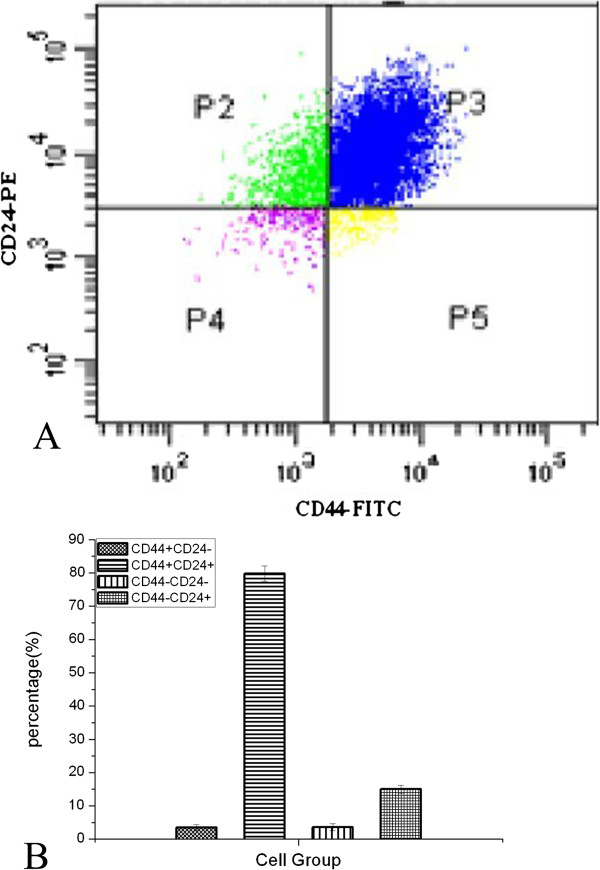
Flow cytometry sorting of MCF7 cells using CD44 and CD24 markers. A, MCF7 cells were analyzed by fluorescence-activated cell sorting (FACS) using anti-CD44 and anti-CD24 antibodies. B, Quantification of the four subsets of MCF7 cells. C, Confirmation of the purity of the CD44+/CD24-/low cell type using flow cytometry.